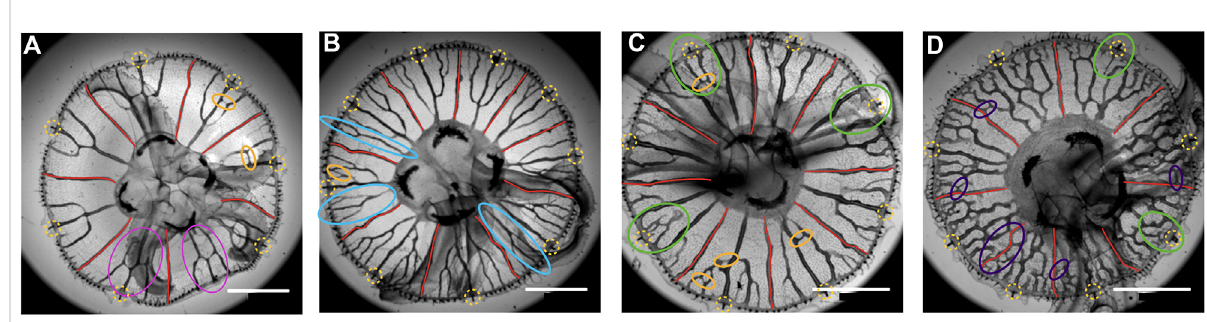
FIGURE 5 Four Aurelia specimens of around the same size, from Cherbourg. The rhopalia are surrounded by yellow-dashed circles, and the adradial canals are drawn in red. In A , the continuation of canals after connecting to the central one is indicated by pink ellipses. In (A – C), some